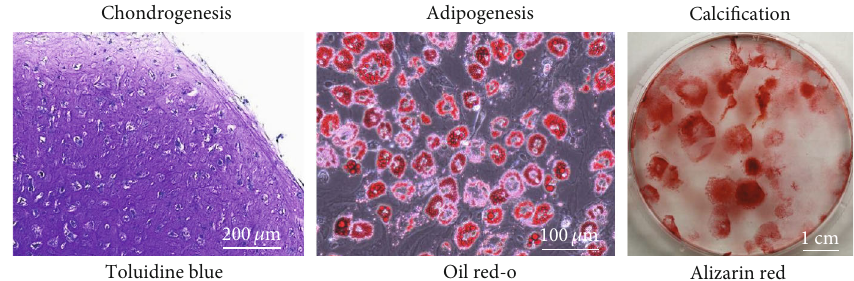
Figure 1: Multipotency of synovial MSCs. Synovial MSCs were cultured in chondrogenic, adipogenic, and calci fi cation induction media. A section of the cartilage pellet was stained with toluidine blue, and the culture dishes for adipogenesis and calci fi cation were stained with oil red O and alizarin red,